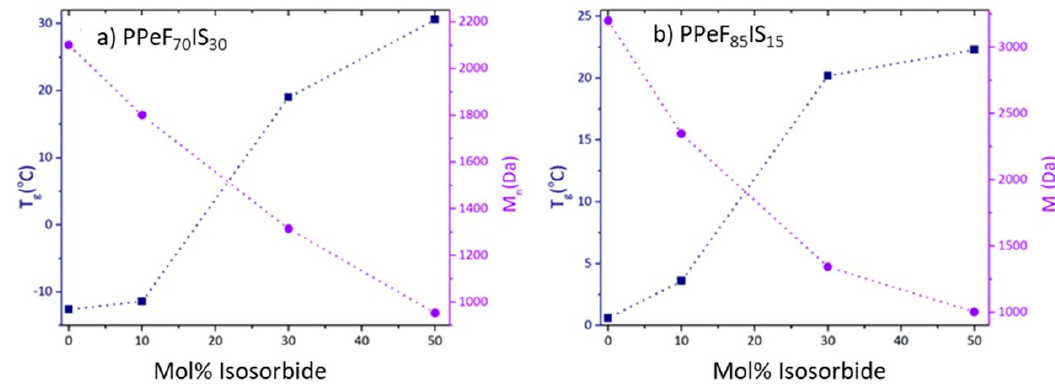
Figure 6. T g and M n as a function of mol % isosorbide for ( a ) PPeF 70 IS 30 and ( b ) PPeF 85 IS 15 .